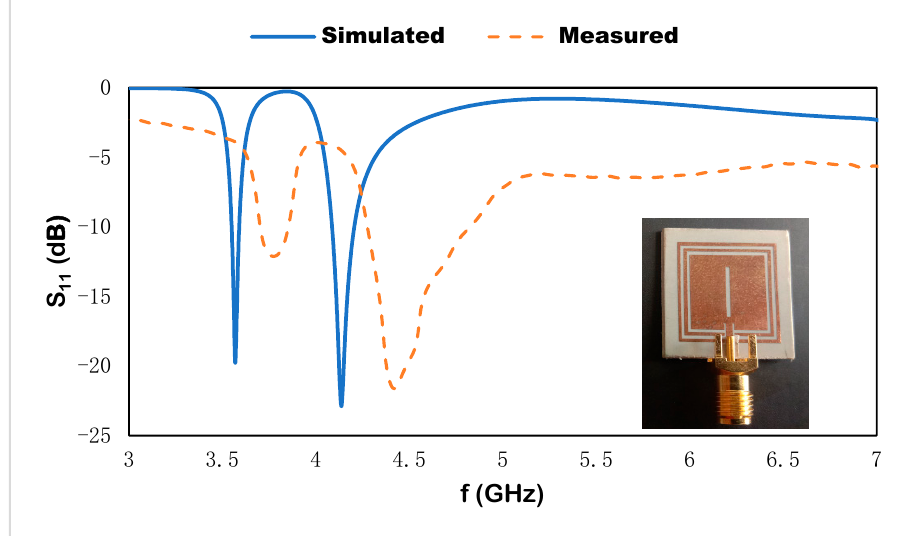
Figure 11. Simulated result and measured results of the reflection coefficient.